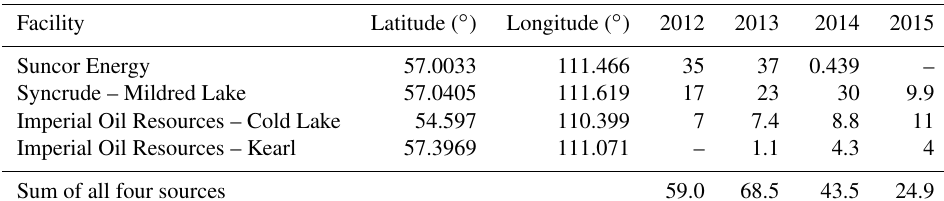
Table 1. Athabasca oil sands Hg emissions (all in kgyr − 1 ) reported to NPRI by oil sands processing facilities and used in the model. For the location of facilities in the AOSR see Fig.